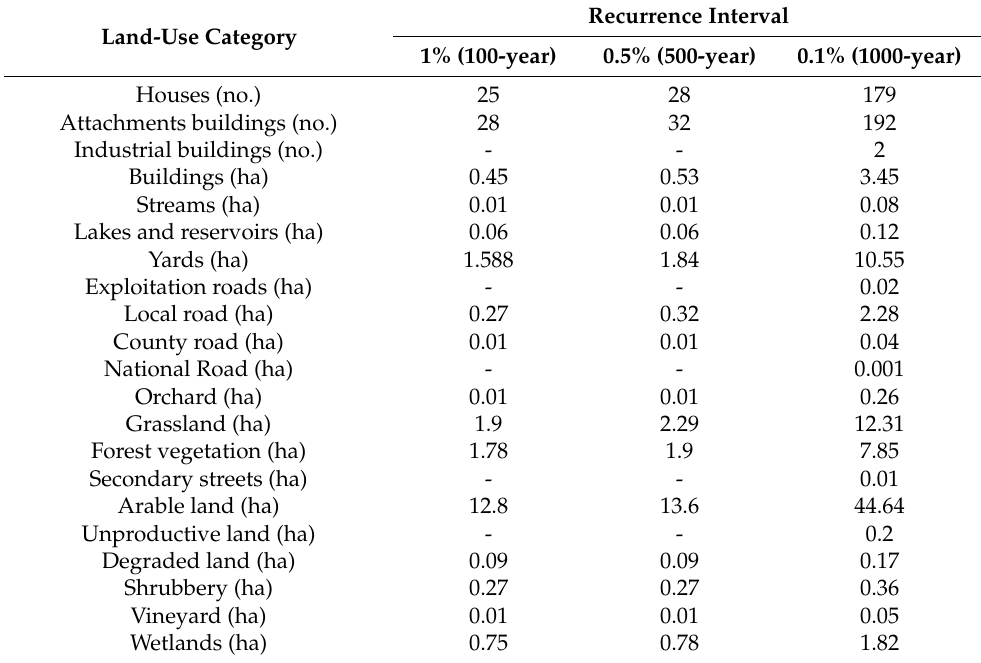
Table 6. Potentially affected land-use categories within built-up area by flood waves computed for each dam break scenario with 1% (100-year), 0.5% (500-year), and 0.1% (1000-year) recurrence intervals. Recurrence Interval Land-Use Category 1% (100-year) 0.5% (500-year) 0.1% (1000-year) Houses (no.) 28 179 Attachments buildings (no.) 28 32 192 Industrial buildings (no.) - - Buildings (ha)